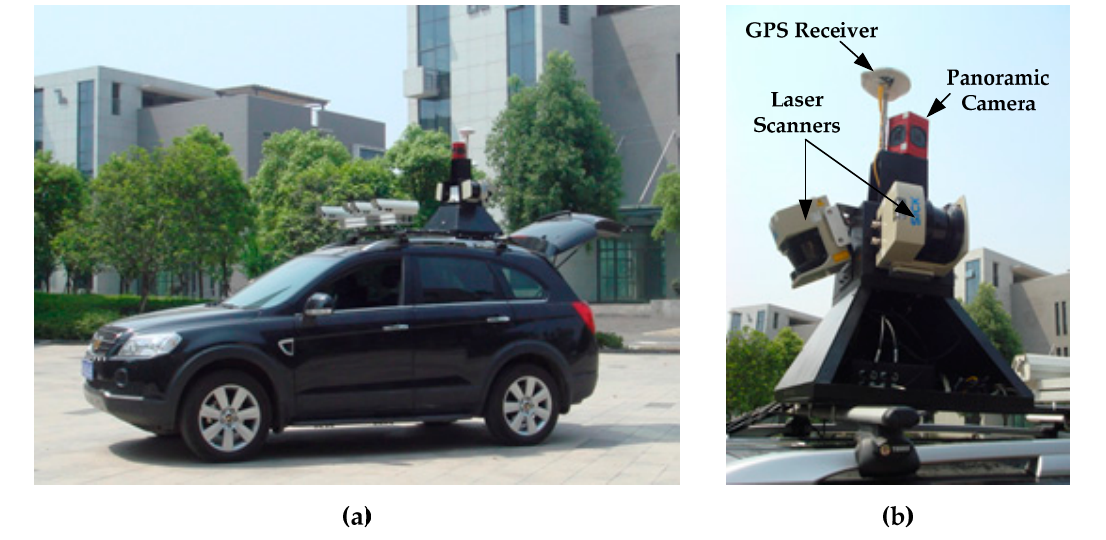
Figure 1. The MMS used in this study: ( a ) the vehicle; ( b ) the panoramic camera, laser scanners, and GPS receiver.